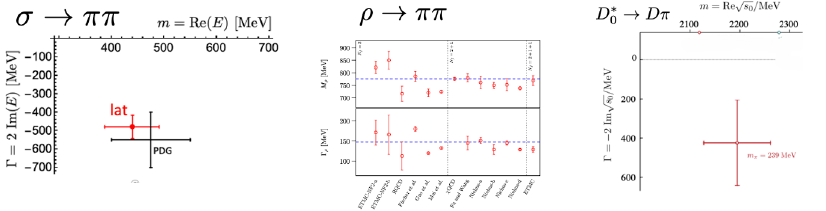
Figure 2. Pole positions for the scalar resonances σ [7] and D ∗ resonances parameters for ρ